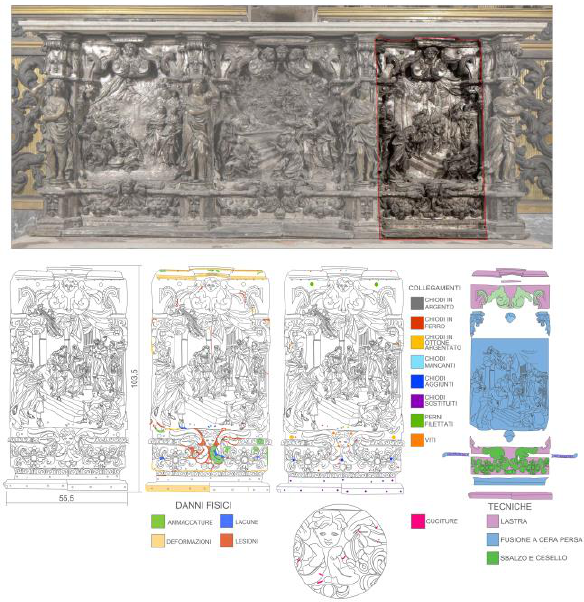
Figure 10 . Thematic mapping of the altar frontal: decay mapping, intervention techniques and connection systems